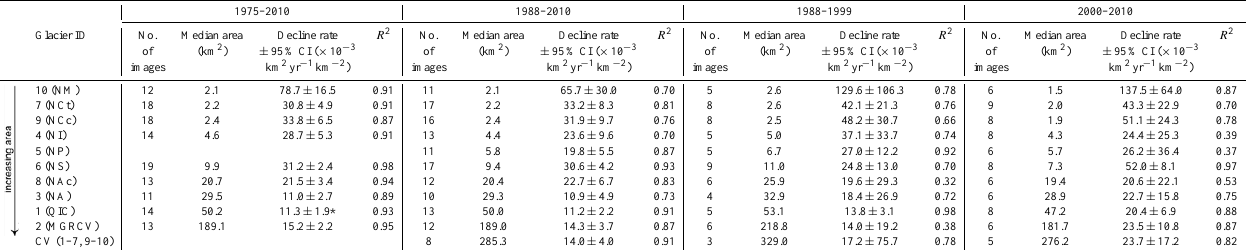
Table 3. Normalized (against median area) glacial decline rates using minimum areas for each year for each Glacial ID throughout the Cordillera Vilcanota (IDs 1–7, 9–10) and just beyond (ID 8) for four different time periods: 1975–2010 (the whole time series, including Corona and MSS imagery), 1988–2010 (the densest time series, Landsat TM/ETM + and ASTER), 1988–1999 (which roughly represents the 1990s but with additional 1988 data points to strengthen the regression), and 2000–2010 (the 2000s). CI is the confidence interval. For full Glacial ID names, please refer to Fig. 8. Note that decline rates are listed as positive values. These same decline rates before normalization can be found in the Supplement (Table S2).